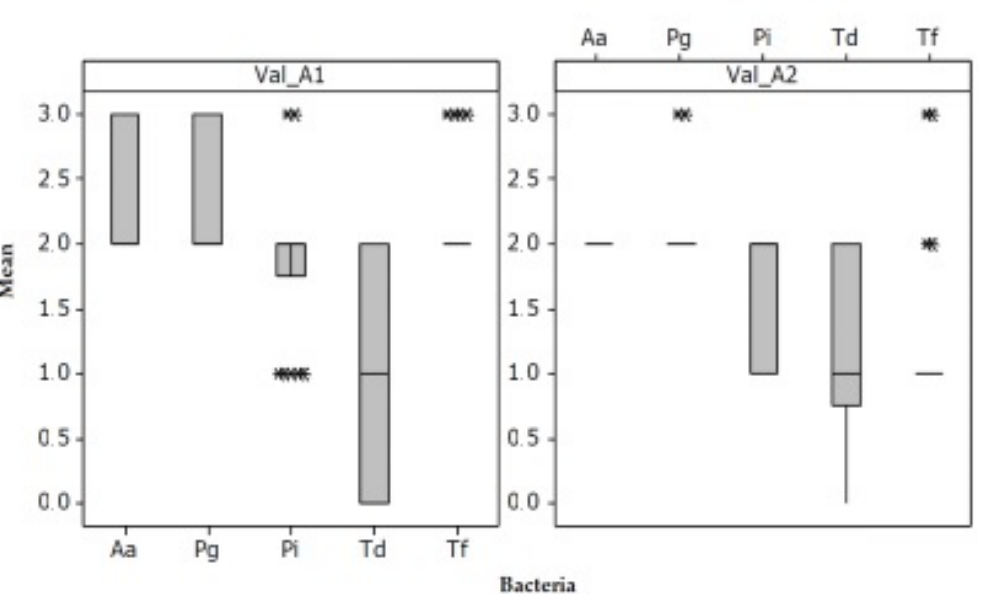
Figure 6. One-way ANOVA-A1 and A2 show that they are significantly different; graph shows: The best results are at Aa and Pg; Poor results are at Pi, Td, even Tf. The median is the dot in the middle of the ‘box’. The upper side of the box is the 1st quartile or 25% of the data, from the rest. The lower side of the box is the 3rd quartile, or 75% of the data, from the rest. The distance between the sides of the box is called the inter-quartile range (IQR). The distance between these is called the range. All treatment procedures reduced statistically significantly (each p < 0.01) the total bacterial counts. The same comparison as for conventional treatment was applied for combined treatment (SRP + aPDT) and statistics reveal significant bacterial reduction between initial group B1 and combined treatment group SRP + aPDT, B2. (Figures 7 and